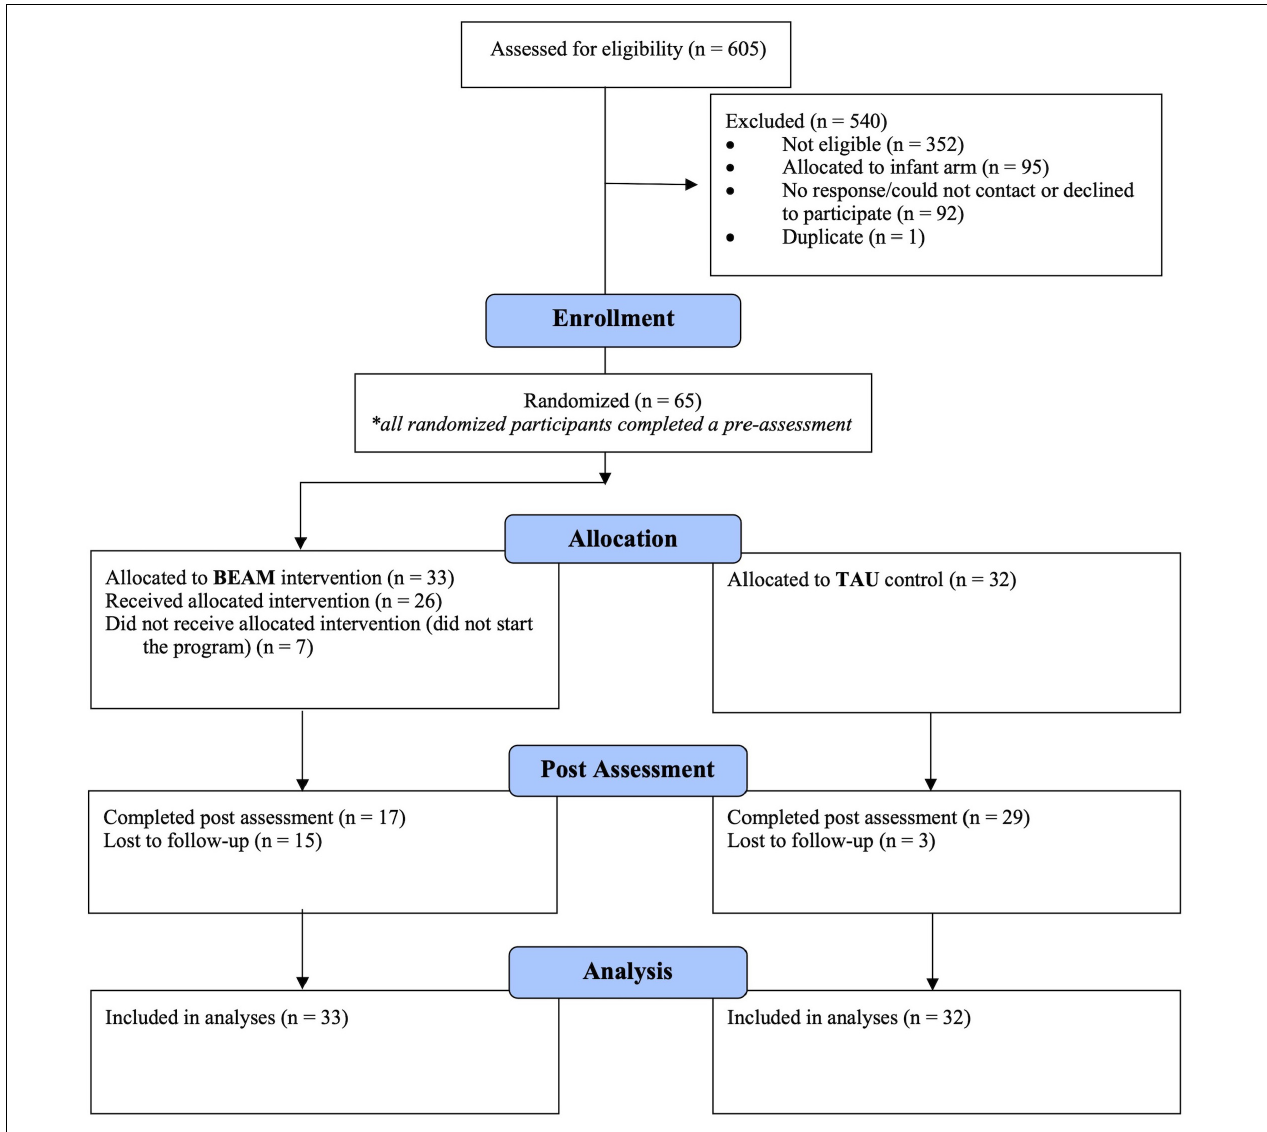
FIGURE 2 | CONSORT flow